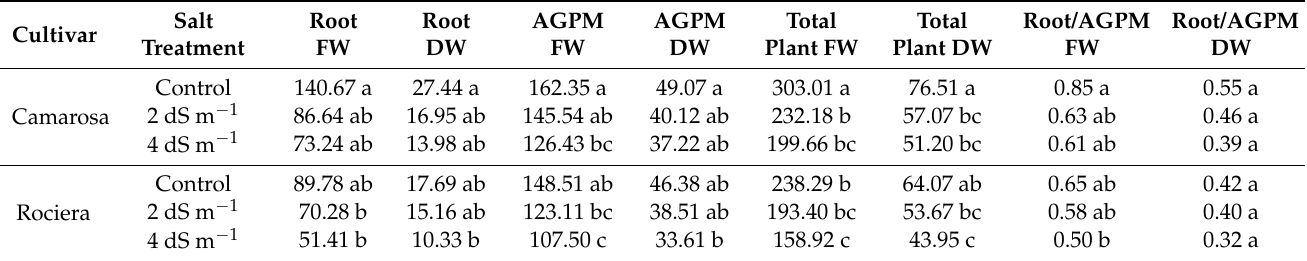
Table 9. Effect of salt stress on the strawberry root, above-ground plant mass (AGPM), and total plant fresh and dry weight (FW and